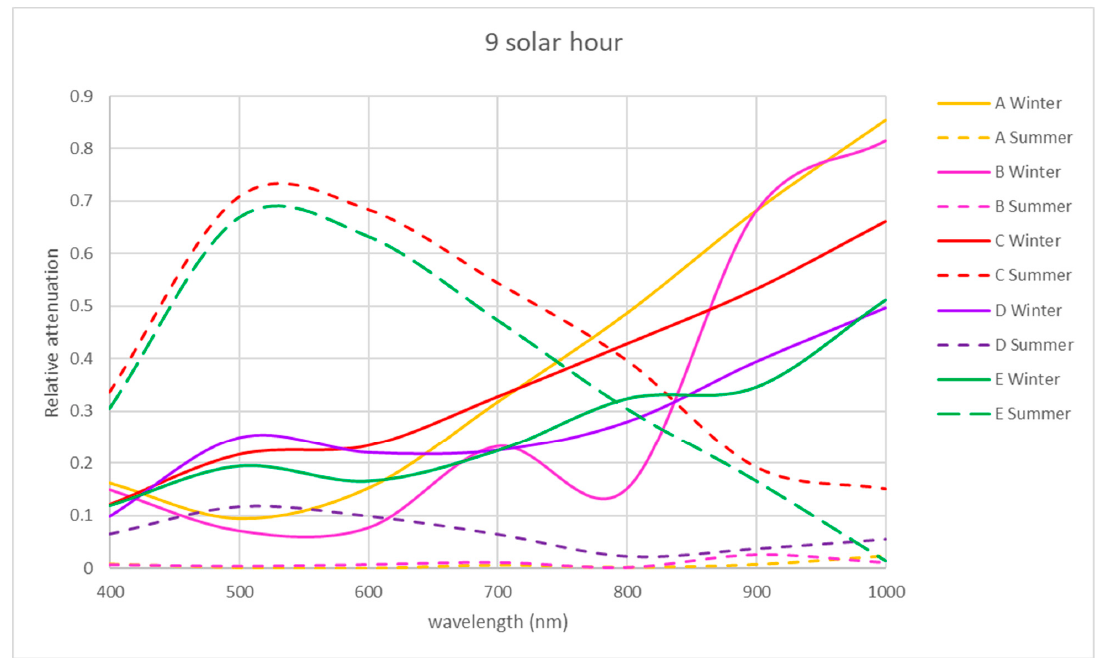
Figure 8. Representation of the spectral relative attenuation for the VIS and NIR bands for the 5 locations studied in two seasons of the year at 9:00 a.m. solar time.